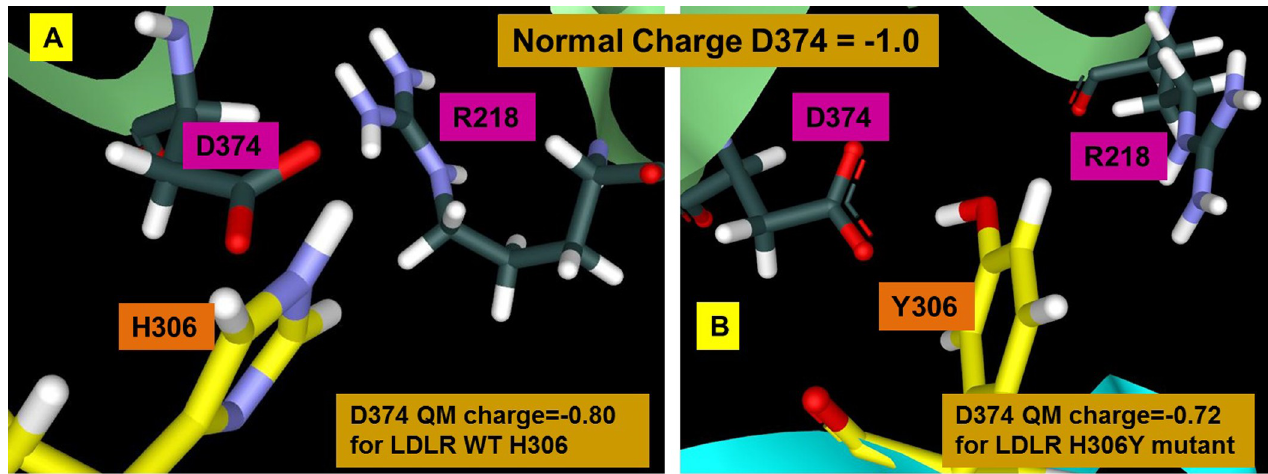
Fig 5. LDLR interaction changes the PCSK9 D374 charge. GAMESS/RESP calculations were run on the complex between PCSK9 and wild type LDLR (PDB ID 3bps) and on PCSK9 complexed with the FH mutant LDLR H306Y (PDB ID 3gcw) with all of the amino acids forming the extended interface shown in Fig 1. Amber parameters assign partial charges to the atoms of an aspartate such that the total charge on the residue is -1. The charge on D374 is reduced by 20% in the wild type (A) complex and by 28% in the FH mutant (B) complex.